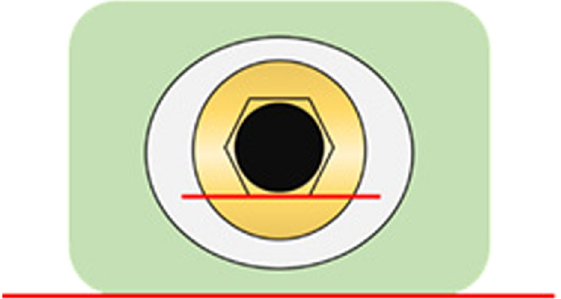
Fig. 5 Specimen in putty mold (green), axial view. Red lines representing fl at surface parallel to one hexagonal